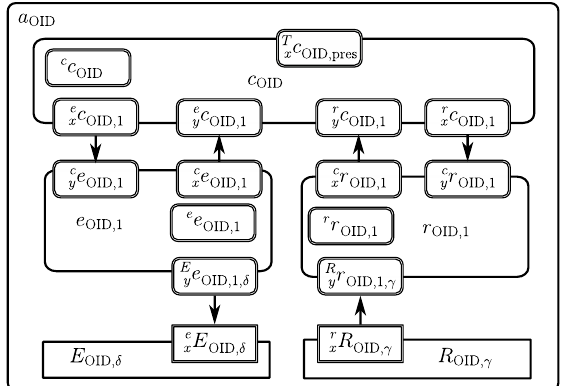
Figure 7. Structure of the agent a OID , where γ ∈ { mouse, keyboard, touch screen } , δ ∈ { mainPointer, secPointer, keyExecutor } .